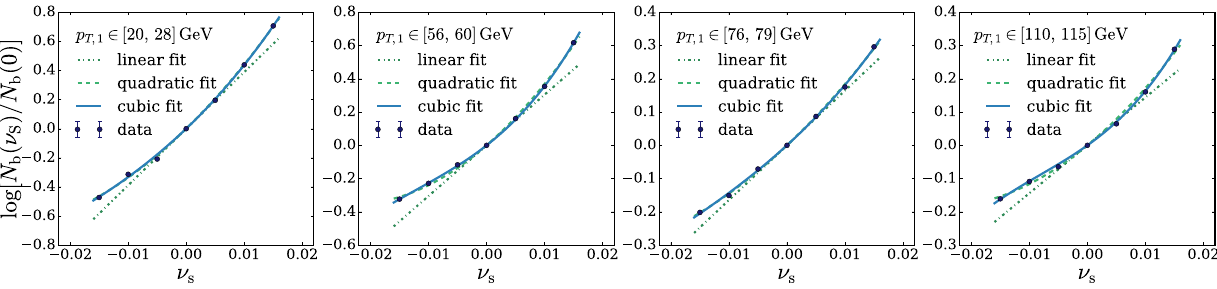
Fig. 13 The dependence on ν s of log N b (ν s )/ N b ( 0 ) in selected bins of the transverse momentum distribution. The dots represent the true value of the log-ratio. The linear, quadratic fits are performed using a subset of the true values points within ± 0 . 01. The quartic one also considers points at ± 0 .